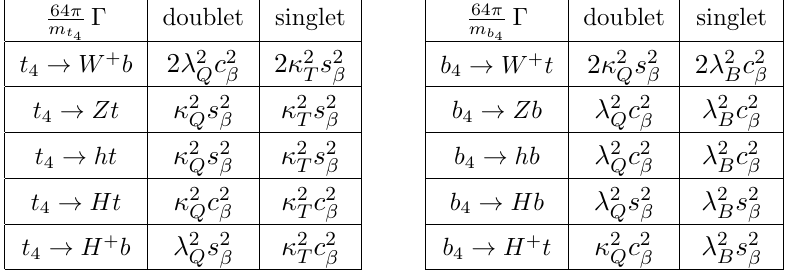
Table 2 . Leading dependence of the t 4 and b 4 decay widths on the Lagrangian parameters in